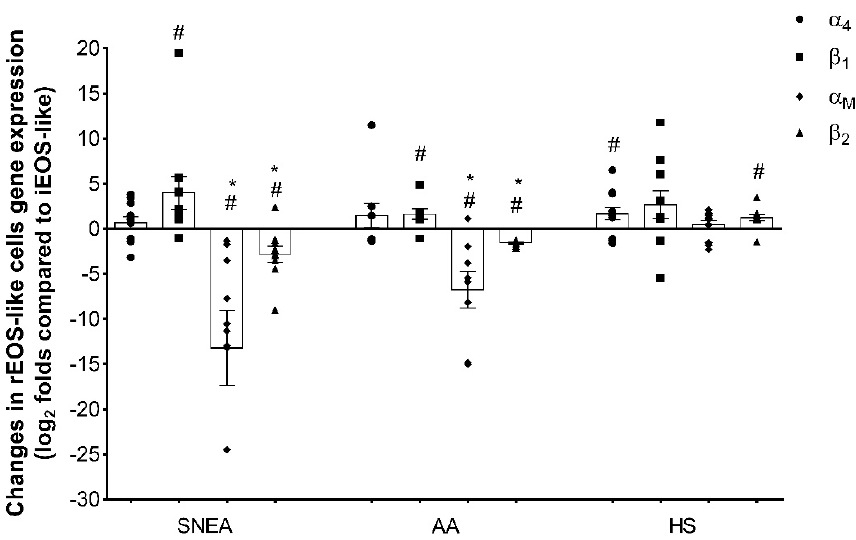
Figure 4. Gene expression of eosinophil subtypes, α 4 β 1 and α M β 2 integrins. SNEA, severe non-allergic eosinophilic asthma; AA, allergic asthma; HS, healthy subjects. AA patients, n = 9; SNEA patients, n = 11; HS, n = 12. * p < 0.05 compared with the HS group; # p < 0.05 compared with iEOS. Results are presented as the mean ± standard error. Statistical analysis between investigated groups, Mann–Whitney two-sided U-test; within one study group, comparing each point of the subject individually, Wilcoxon matched-pair, signed-rank, two-sided test.